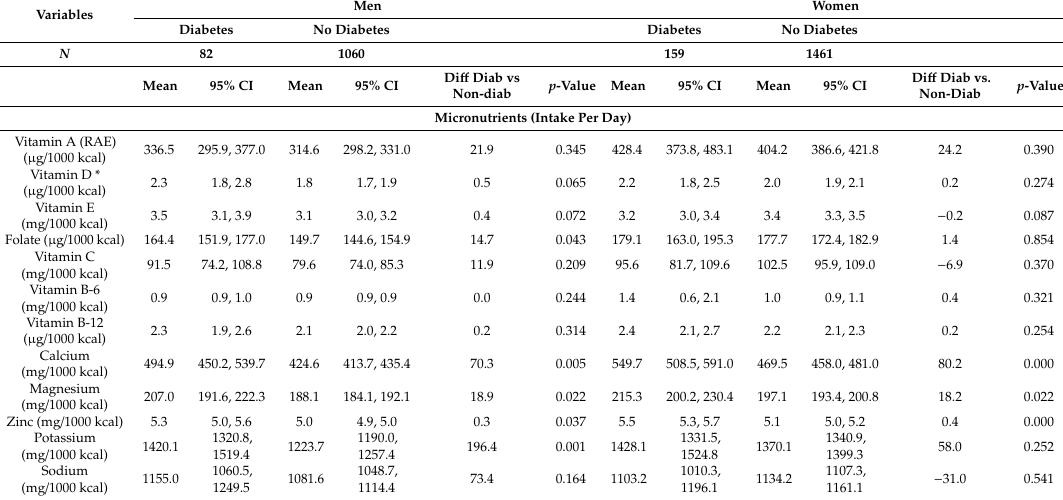
Table 5. Sex-stratified adjusted intakes of micronutrients in Mexican adults by diabetes status ( n = 2762) a . Variables Men Women Diabetes NoDiabetes Diabetes NoDiabetes N